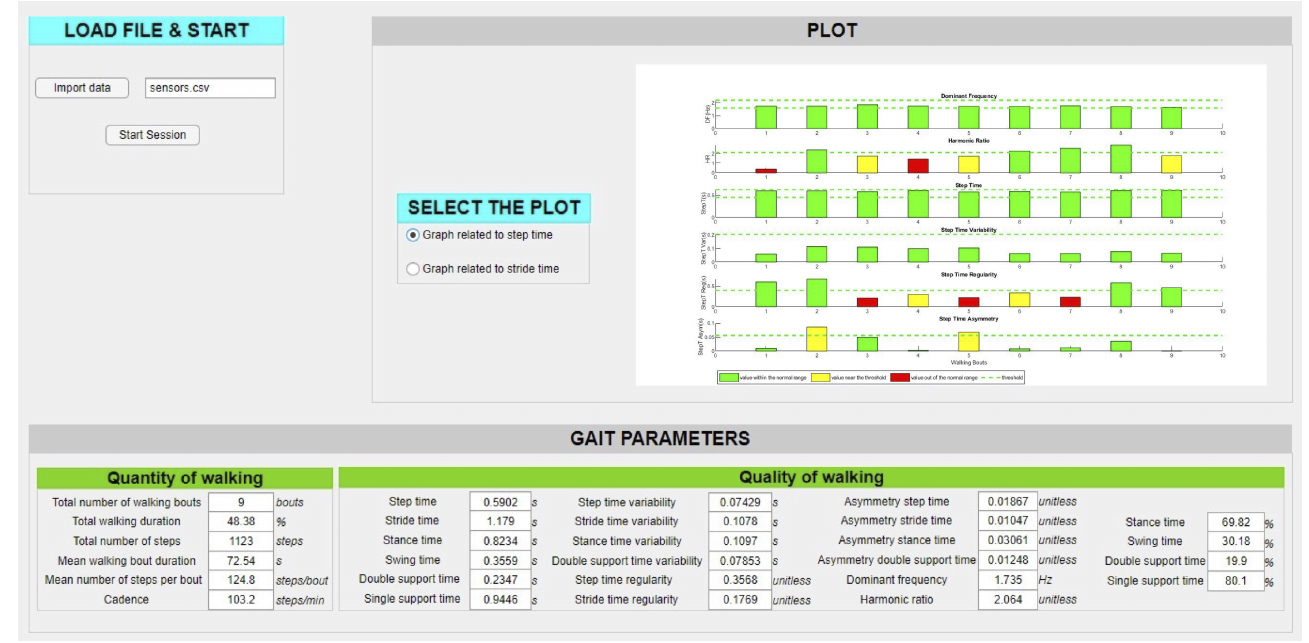
Figure 5. Graphical User Interface of the final report on the PD subject’s health state, where the extracted parameters (in the bottom ) and the histograms of the patient status (on the right ) are